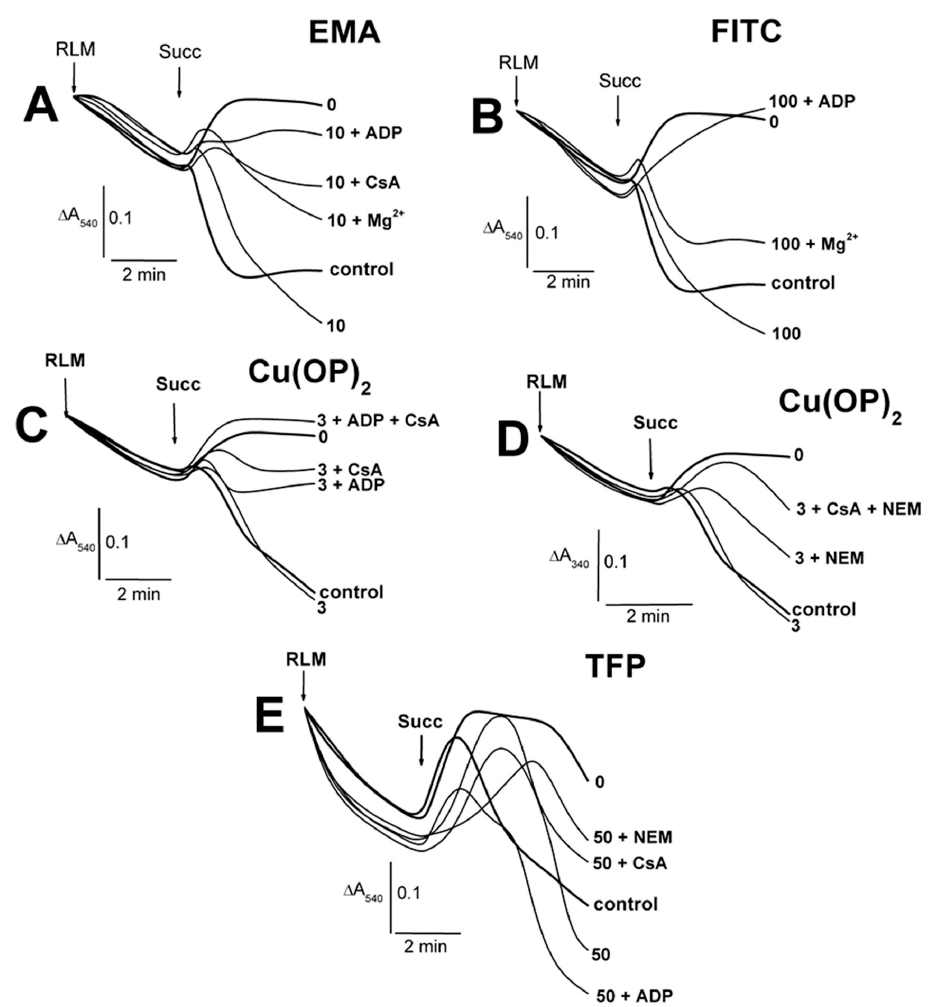
Figure 7. The influence of EMA, FITC, Cu(OP) 2 , and TFP on the Tl + -induced swelling of calcium- loaded rat liver mitochondria. Mitochondria (1.5 mg of protein per mL) were added into the medium A (pH 7.3) containing 75 mM TlNO 3 and 75 µ M Ca 2+ . The numbers on the right of the traces show concentrations ( µ M) of EMA ( A ), FITC ( B ), Cu(OP) 2 ( C , D ), and TFP ( E ), which were injected into the medium before mitochondria. Additions of mitochondria (RLM) and 5 mM succinate (Succ) are shown by arrows. The medium (where indicated) was additionally supplemented by 500 µ M ADP (ADP), 1 µ M CsA (CsA), and 50 µ M NEM (NEM). The bold traces show experiments free of Ca 2+ (0) or ones with Ca 2+ alone (control).